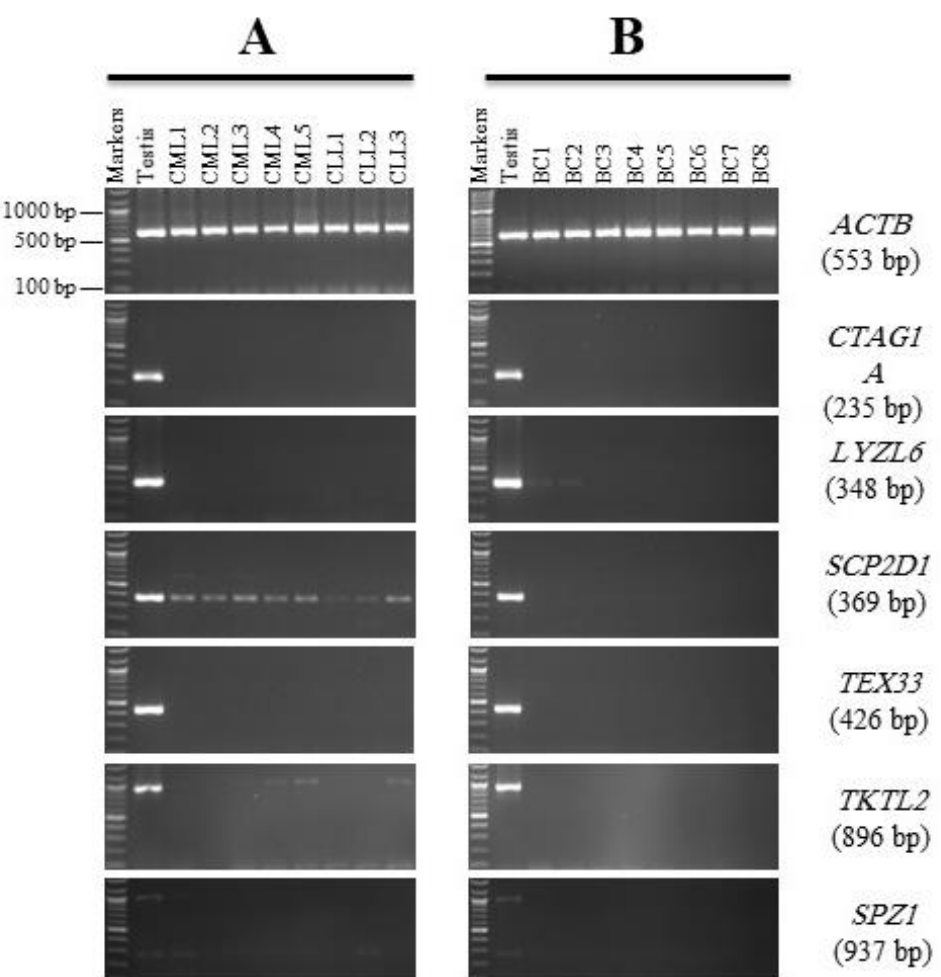
Figure 4. RT-PCR expression profiles for the candidate colon cancer markers in leukemia and breast cancer (BC) tissues. Agarose gels display the RT-PCR analysis for the CTAG1A, LYZL6, SCP2D1, TEX33, TKTL2, and SPZ1 genes. ( A ) cDNAs were synthesized from the total RNA from eight leukemia cancer (chronic myeloid leukemia (CML), and chronic lymphoblastic leukemia (CLL)). ( B ) cDNAs were synthesized from the total RNA from BC tissues. ACTB expression was used as a positive control for the cDNA samples. Testis cDNA was used to test the primer for each gene. The expected product size of each gene is presented on the right between brackets.